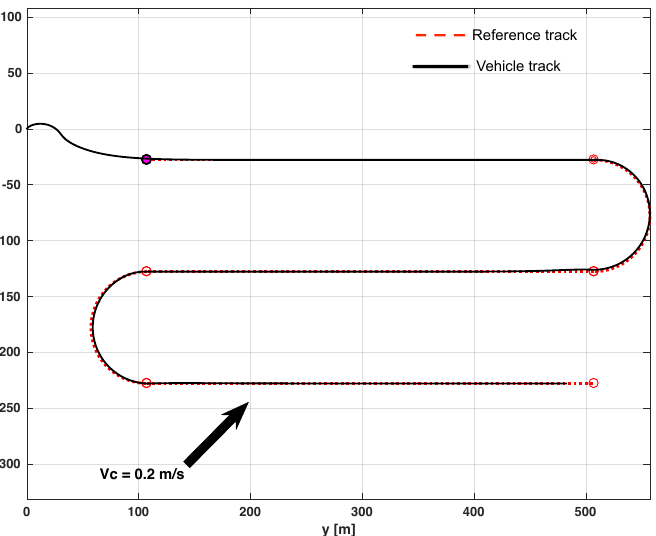
Figure 16. Simulated lawnmowing maneuver of the DELFIM x vehicle in the presence of ocean currents.